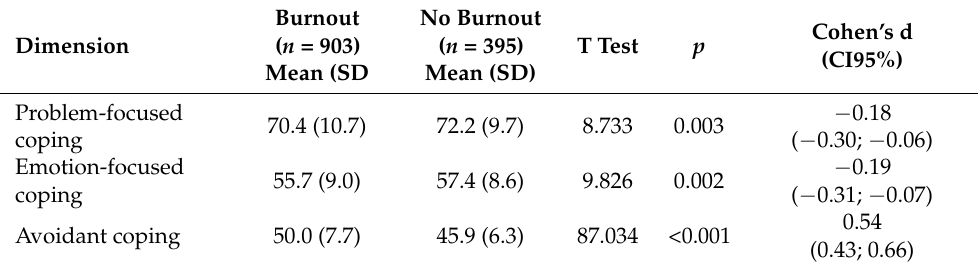
Table 4. Means and standard deviations, independent samples t and p values, and magnitude of the difference between groups in the dimensions of the COPE-28 coping questionnaire, classified by whether high scores in at least one dimension of burnout or no burnout were